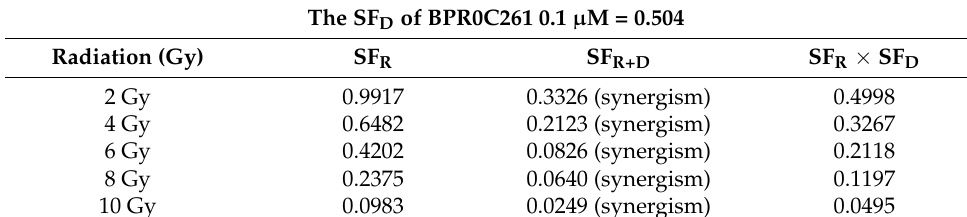
Table 2. Effect of BPR0C261 combining different doses of X-rays on H1299 cells. The SF D of BPR0C261 0.1 µ M =